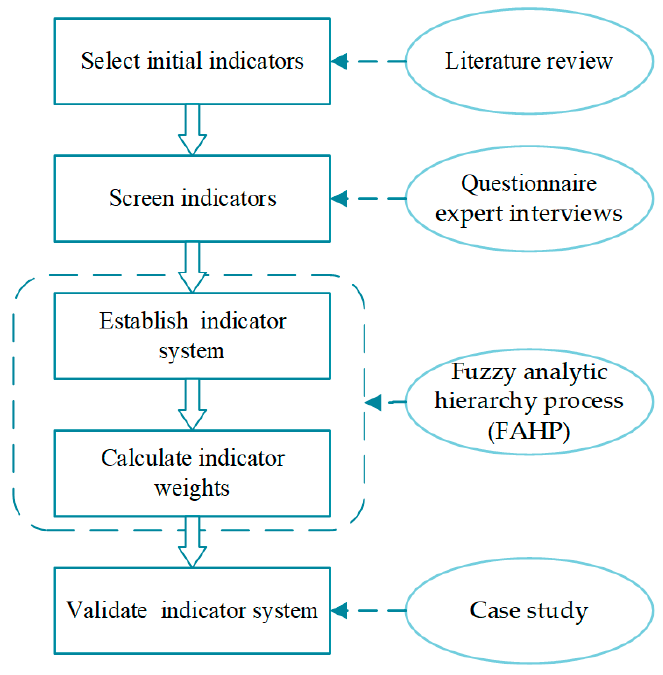
Figure 1. Research framework and process.